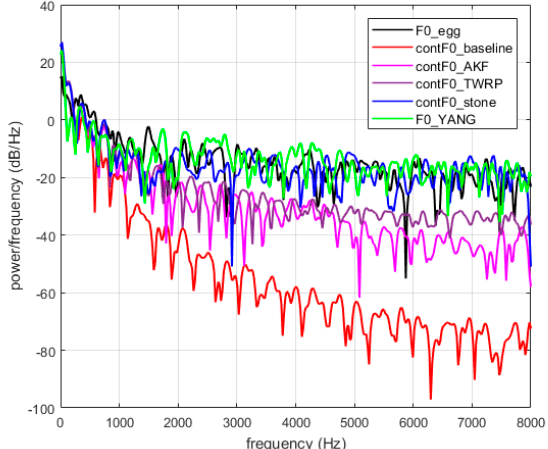
Figure 8. The periodogram estimate of the PSD for the extracted F0 trajectories.